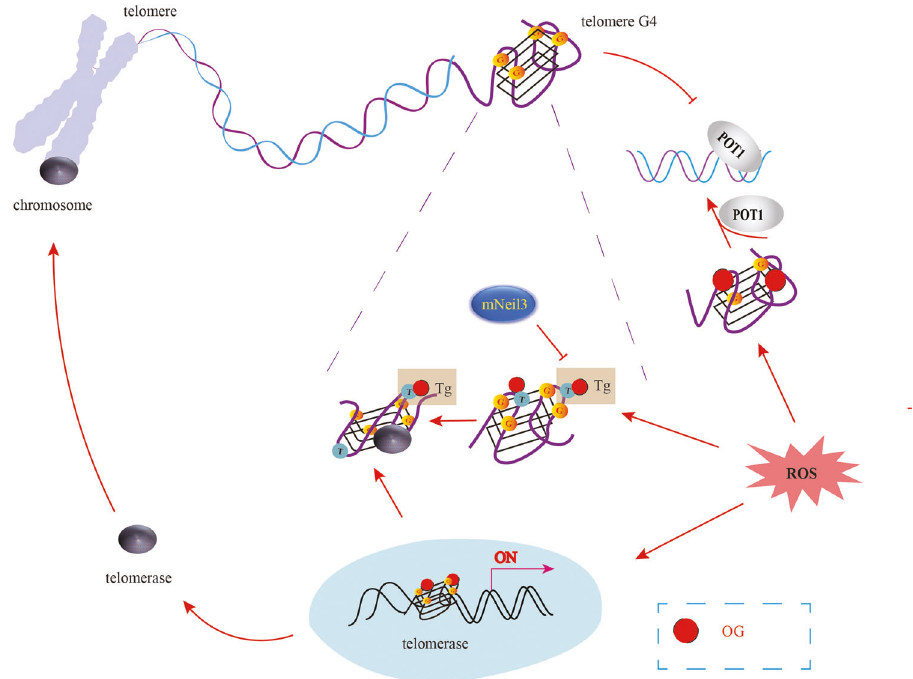
Fig. 4 The role of G4 in ROS-mediated regulation of telomere function. OG can activate telomerase by destabilizing DNA G4 structures and inducing Tg structure at thymine (T), which alters the conformation of original G4 to enhance telomerase binding. Meanwhile, mNeil3 can inhibit the formation of Tg, thereby maintaining the stability of the original G4 structure. On the other hand, OG can reduce telomere G4 stability, unfold their structure, and reduce the rejection of POT1, thereby maintaining the integrity and function of DNA